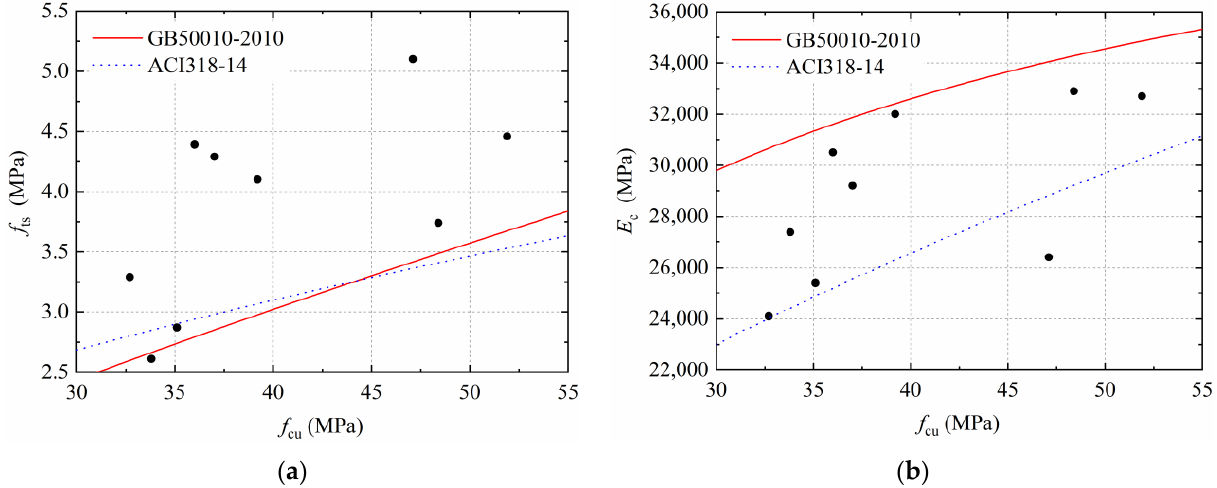
Figure 13. Comparisons between tests and standards: ( a ) Relationship between f cu and f ts ; ( b ) Relationship between f cu and E c .